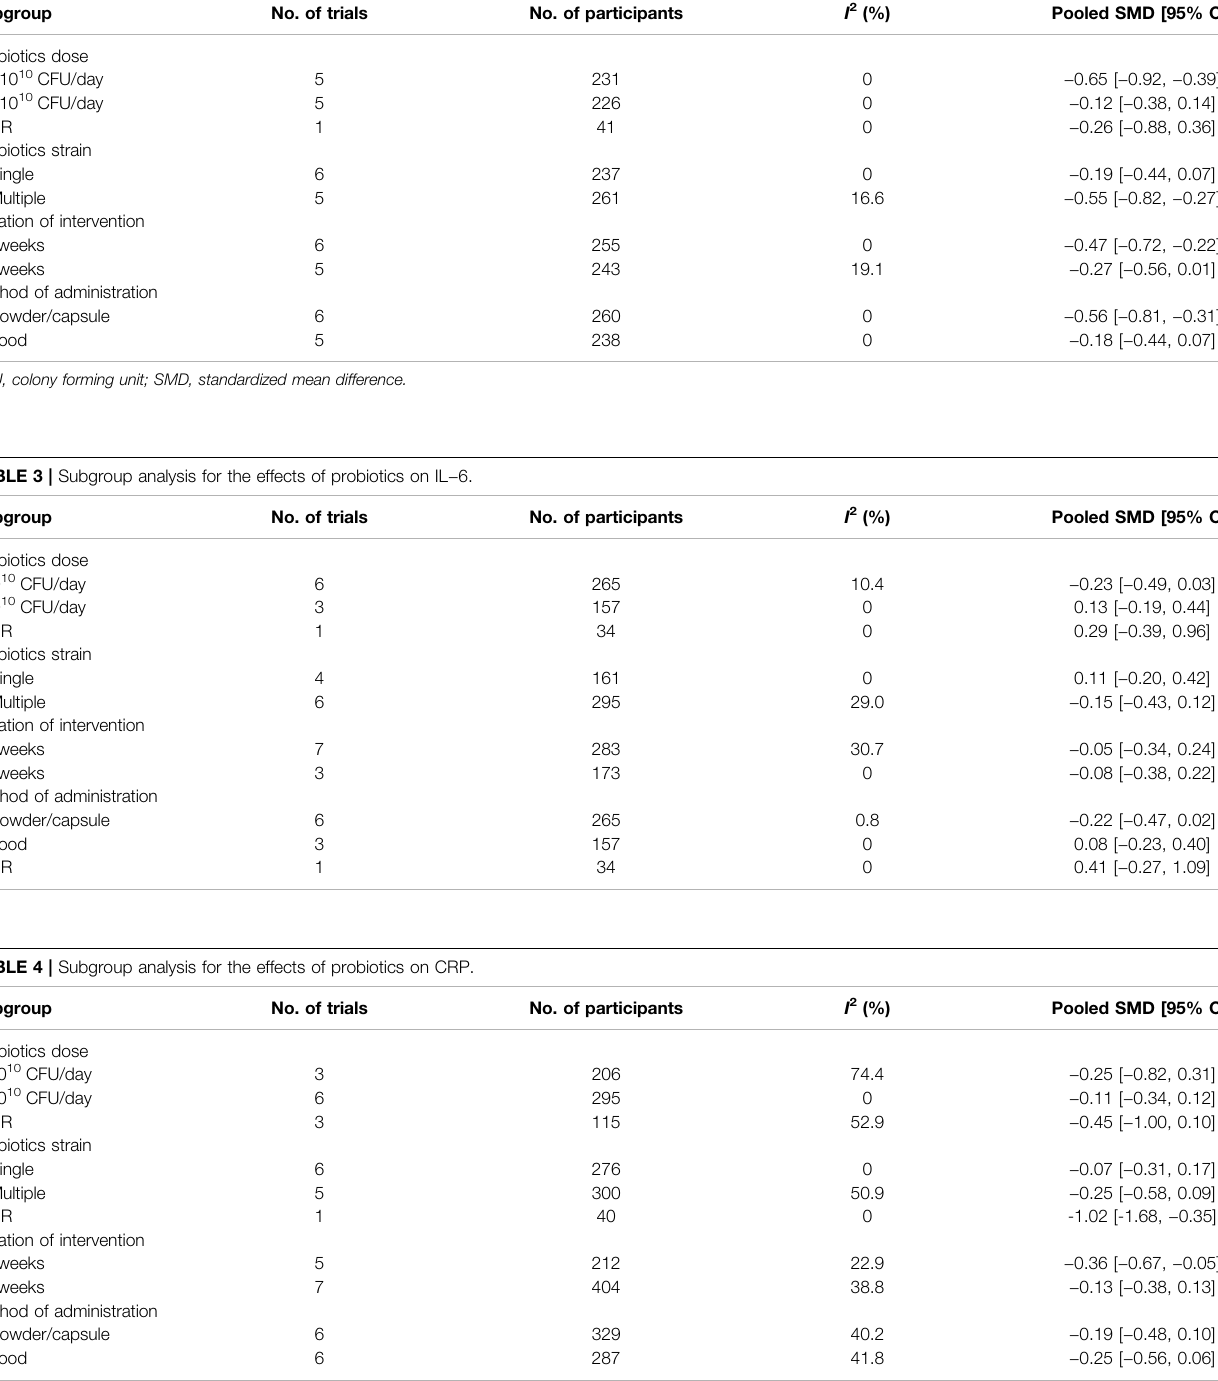
TABLE 2 | Subgroup analysis for the effects of probiotics on TNF- α . Subgroup